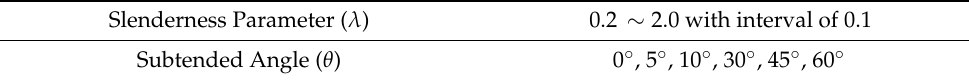
Table 2. Model Parameters.